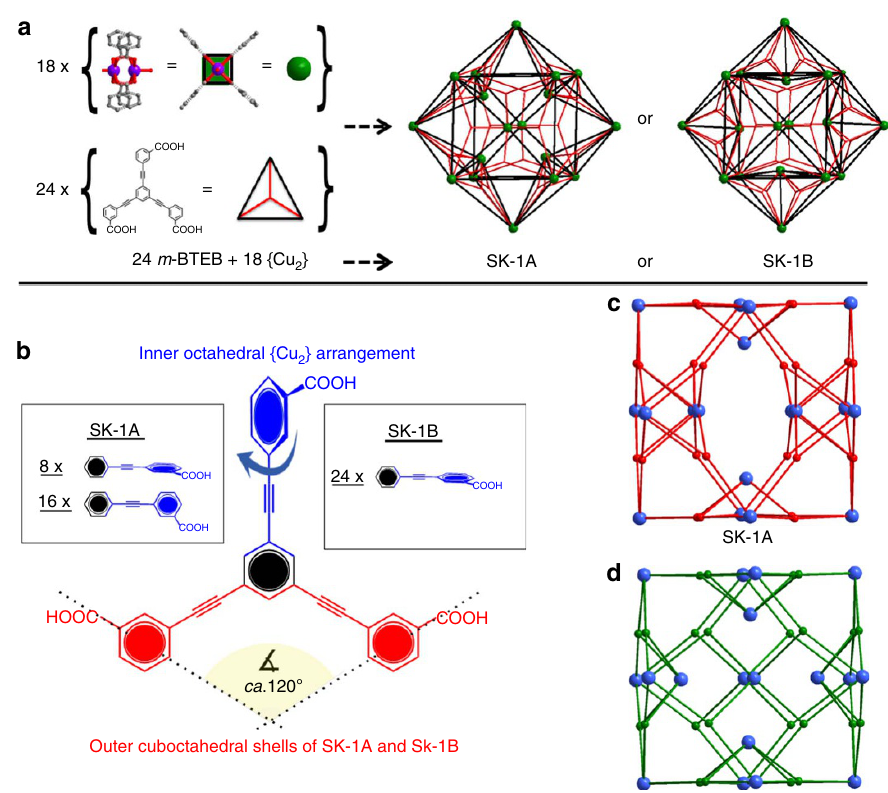
Figure 3 | Ligand structure and benzoate conformations that promote the formation of SK-1. ( a ) Schematic representation of the formation of the coordination cages. ( b ) Arrangement of the benzoate moieties of the m -BTEB ligand in SK-1A and SK-1B. ( c , d ) Topological representations of SK-1A and SK-1B, respectively.